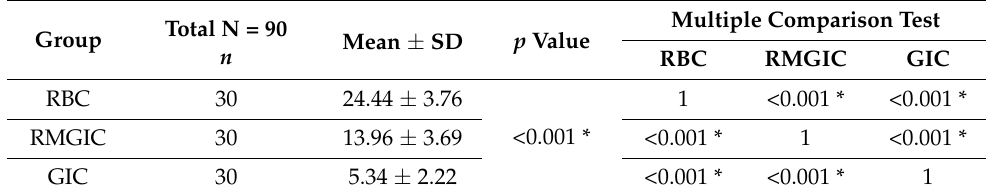
Table 2. The mean and standard deviation (SD) values of the microtensile bond strength in megapas- cal (MPa) based on the type of each group.